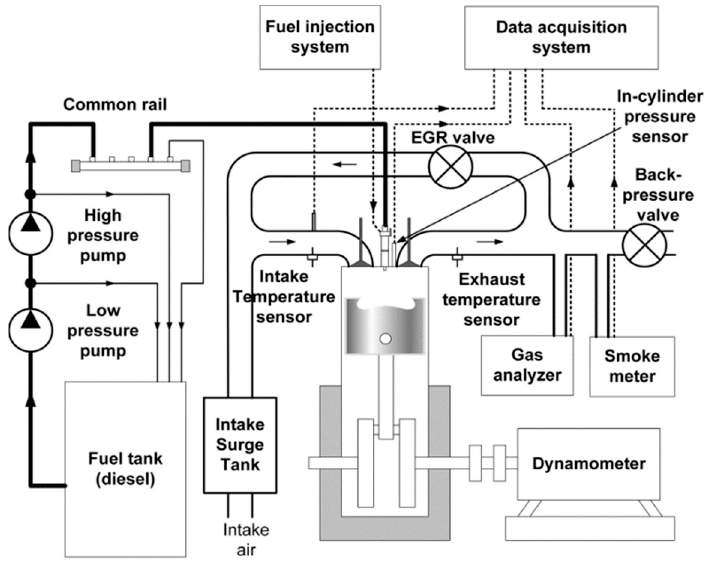
Figure 2. Schematic of 0.5 L single-cylinder diesel engine; EGR: exhaust gas recirculation. Table 2. Specifications of 0.5 L single-cylinder diesel engine.